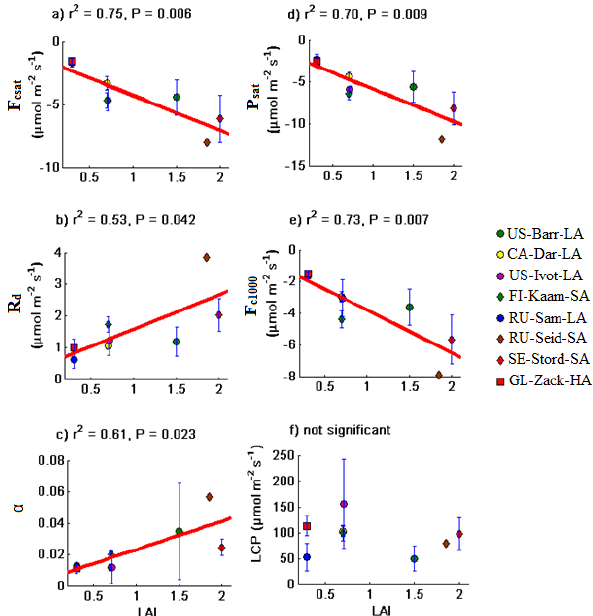
Figure 2. Relationships between maximum LAI and (a) light saturation NEE, F csat ; (b) dark respiration, R d ; (c) rate of car- bon assimilation with initial increase in light, α ; (d) potential photosynthesis at light saturation, P sat ; (e) NEE when PPFD is 1000µmolm − 2 s − 1 , F c 1000 and (f) light compensation point (LCP). Red line represents linear fit between maximum LAI and LRC parameters while error bars are standard